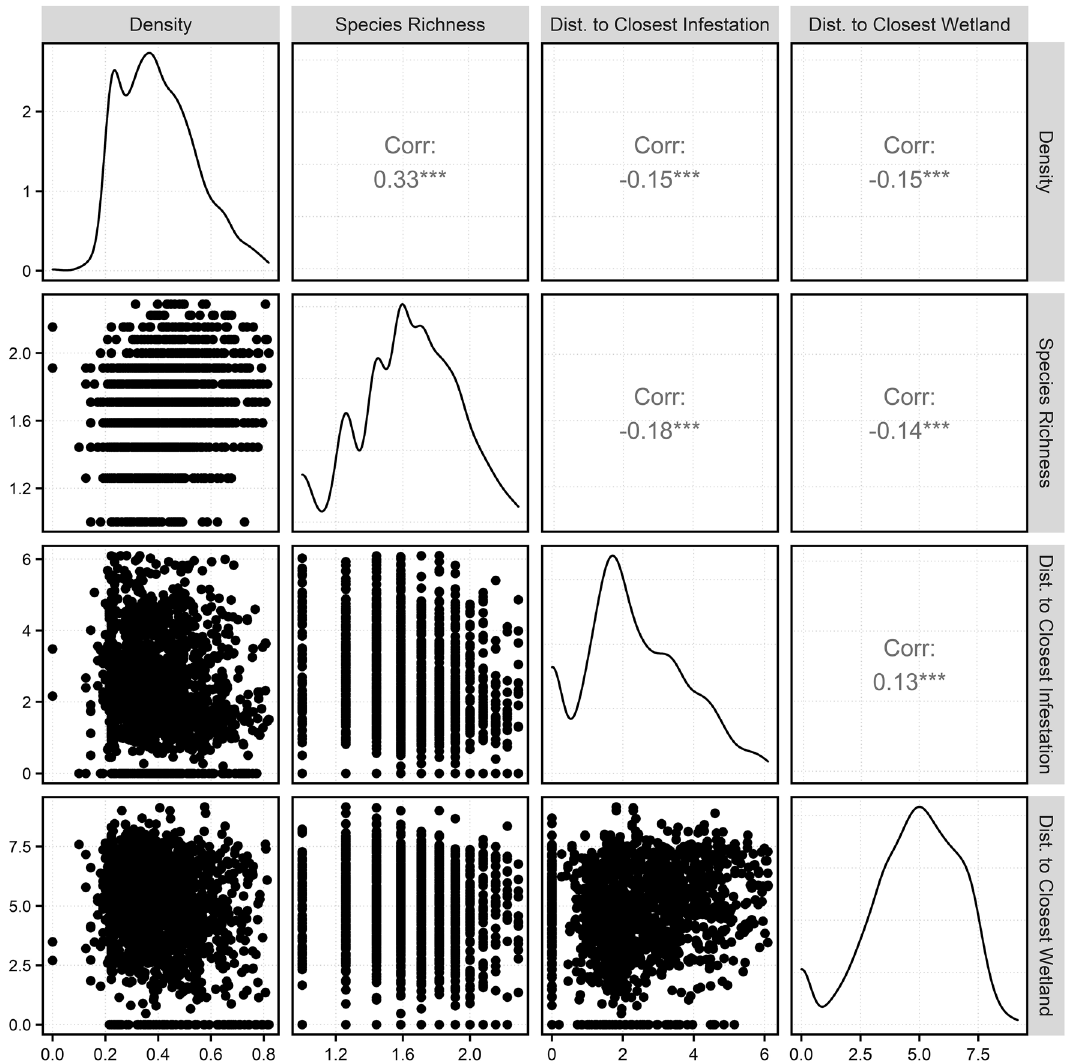
Figure 3. Pairwise plots to compare the purple loosestrife density (number of plants/m 2 ), plant species richness (number of species), distance to closest infestation (m), and distance to closest wetland (m). Cube root transformation was implemented for all the variables used in the model to normalize the data. Diagonal plots represent the general distribution curve demonstrating normality and the values in the plot represent correlation between the variables. Figure created in RStudio v9.1.372 36 using R v4.1.2 37 .